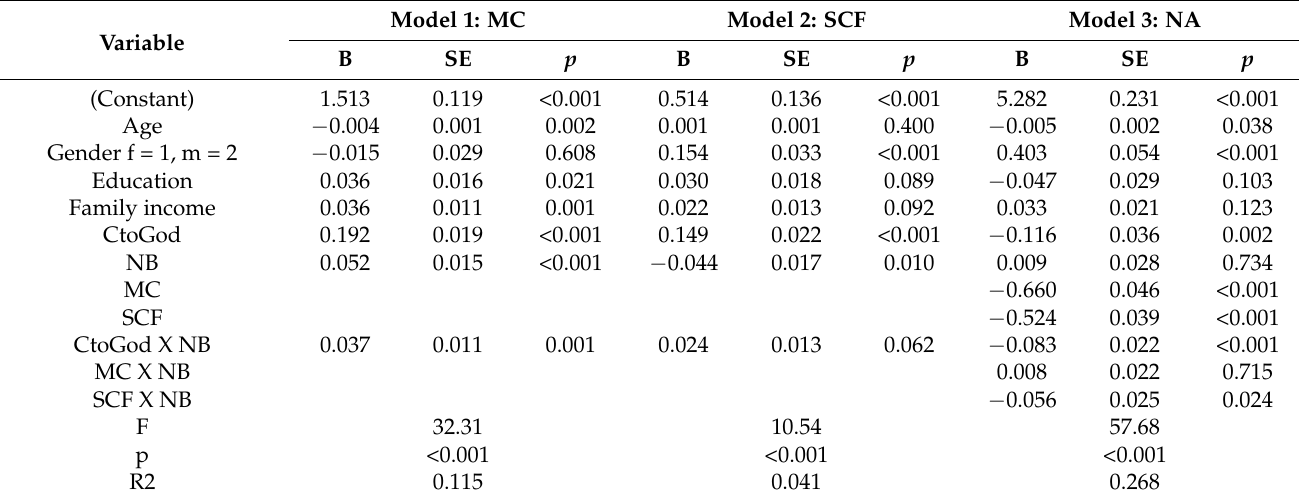
Table 5. Interaction effects on MC, SCF, and NA.